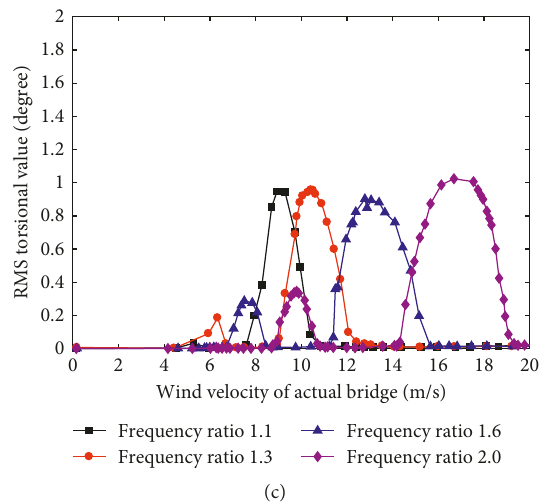
Figure 3: VIV of girder of bridge in different frequency parameters. (a) VIV of dynamic wind tunnel test at 1.12Hz vertical frequency. (b) VIV of dynamic wind tunnel test at 1.50Hz vertical frequency. (c) VIV of dynamic wind tunnel test at 1.89Hz vertical